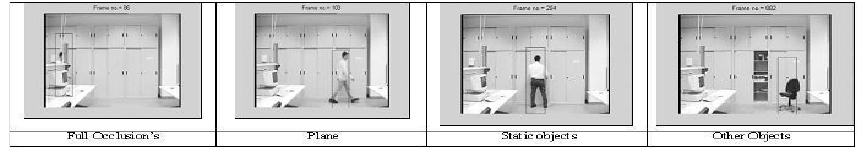
Figure 11. Occlusion in indoor